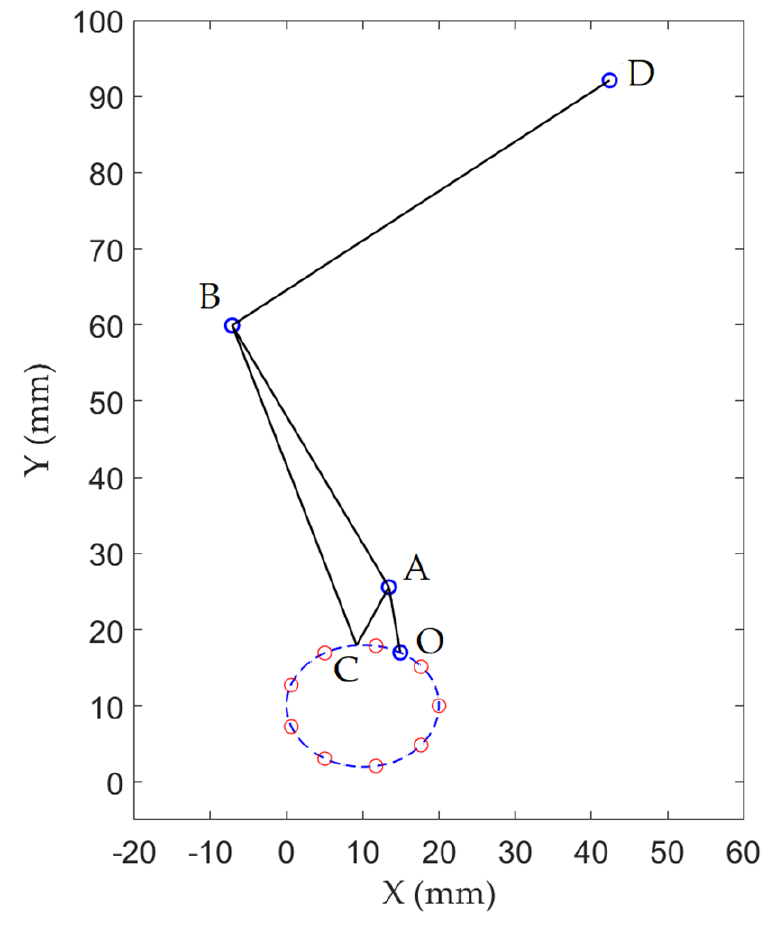
Figure 20. Trajectories of the coupler point of Case 5.